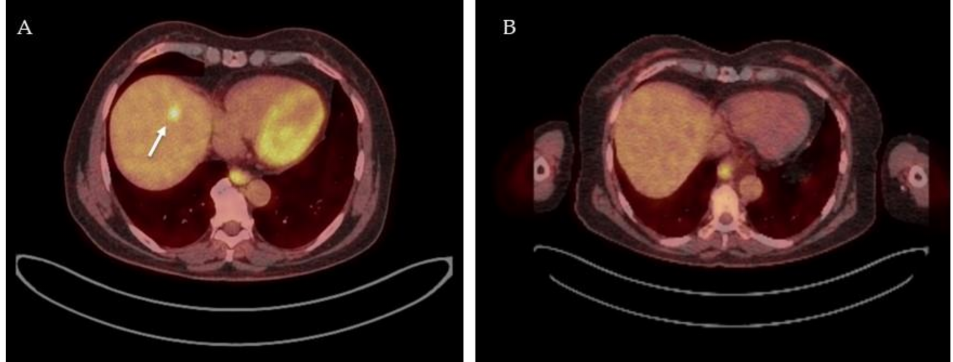
Figure 3. 18 F-FDG PET-CT images of a patient before and after receiving neoadjuvant chemotherapy. 18 F-FDG PET-CT fusion image with high focal FDG uptake in segment 4A indicative of a colorectal liver metastasis, white arrow ( A ); 18 F-FDG PET-CT fusion image after 3 cycles of neoadjuvant chemotherapy (FOLFOXIRI-bevacuzimab) showing solely physiological FDG uptake in healthy liver parenchyma ( B ) indicating a complete metabolic